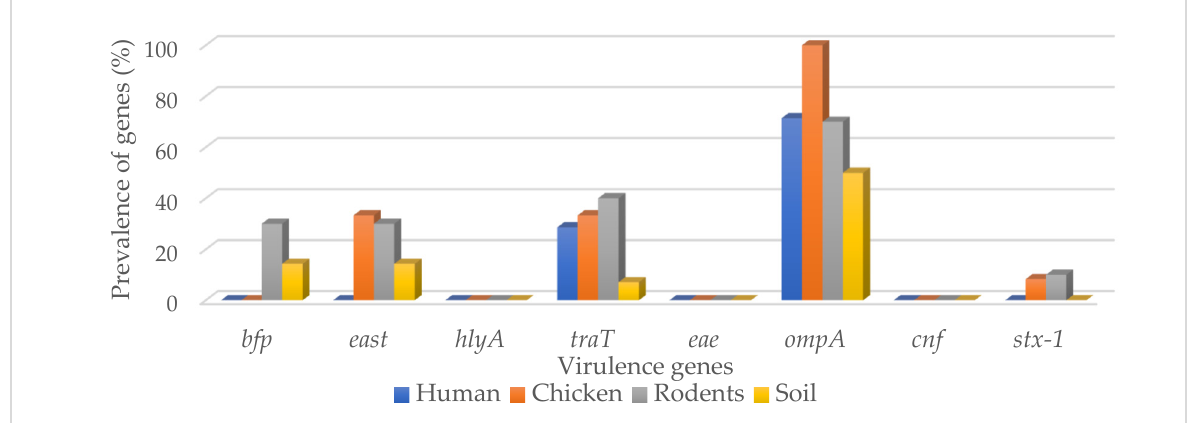
Figure 2. Prevalence of virulence genes in different types of the sample source. 3.3. Comparison between Phenotypic and Genotypic Antibiotic Resistance